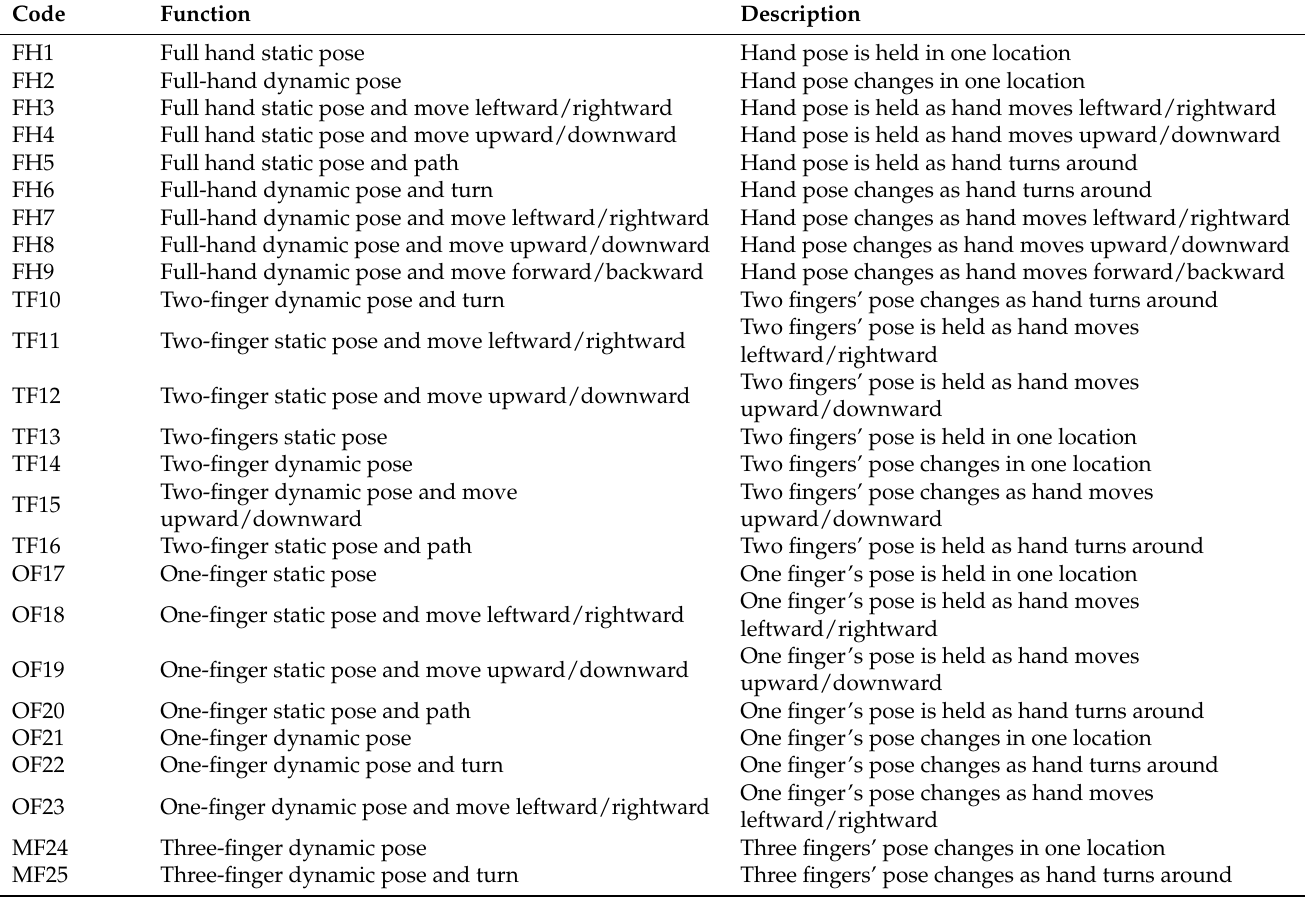
Table 4. Gesture code, function, and description for HomeG for controlling home AC system.